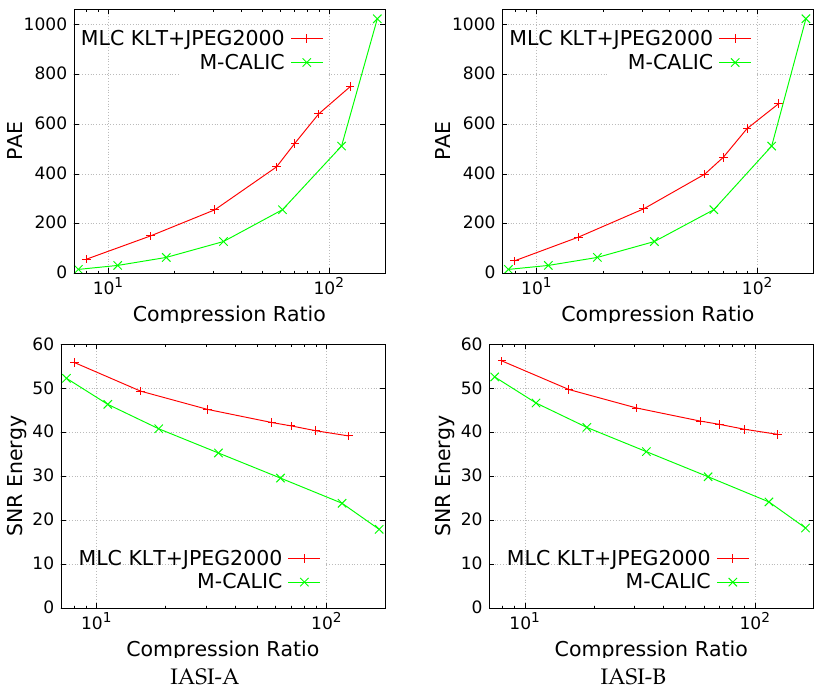
Figure 13. Performance comparison between near-lossless (M-CALIC) and lossy compression (Multilevel Clustering KLT + JPEG 2000). Top row: PAE (lower is better); Bottom row: SNR Energy (in dB, higher is better).